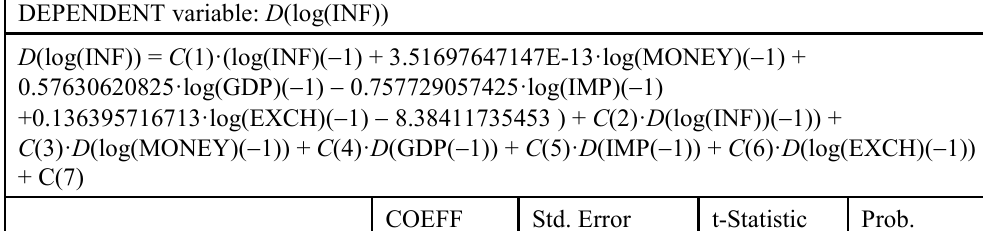
Table 7. VECM Estimation